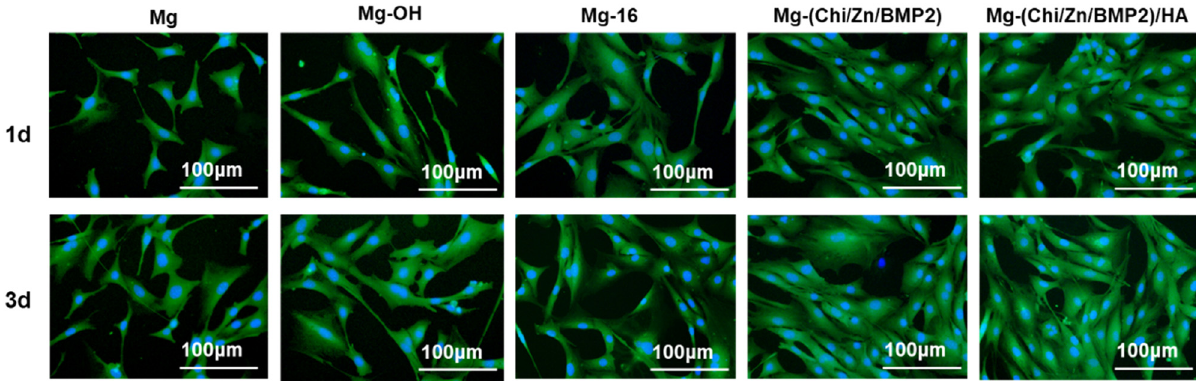
Figure 5: Fluorescence staining of osteoblasts on di ff erent surfaces after being cultured for 1 and 3 days, respectively ( green: cytoplasm, blue: nucleus ) .